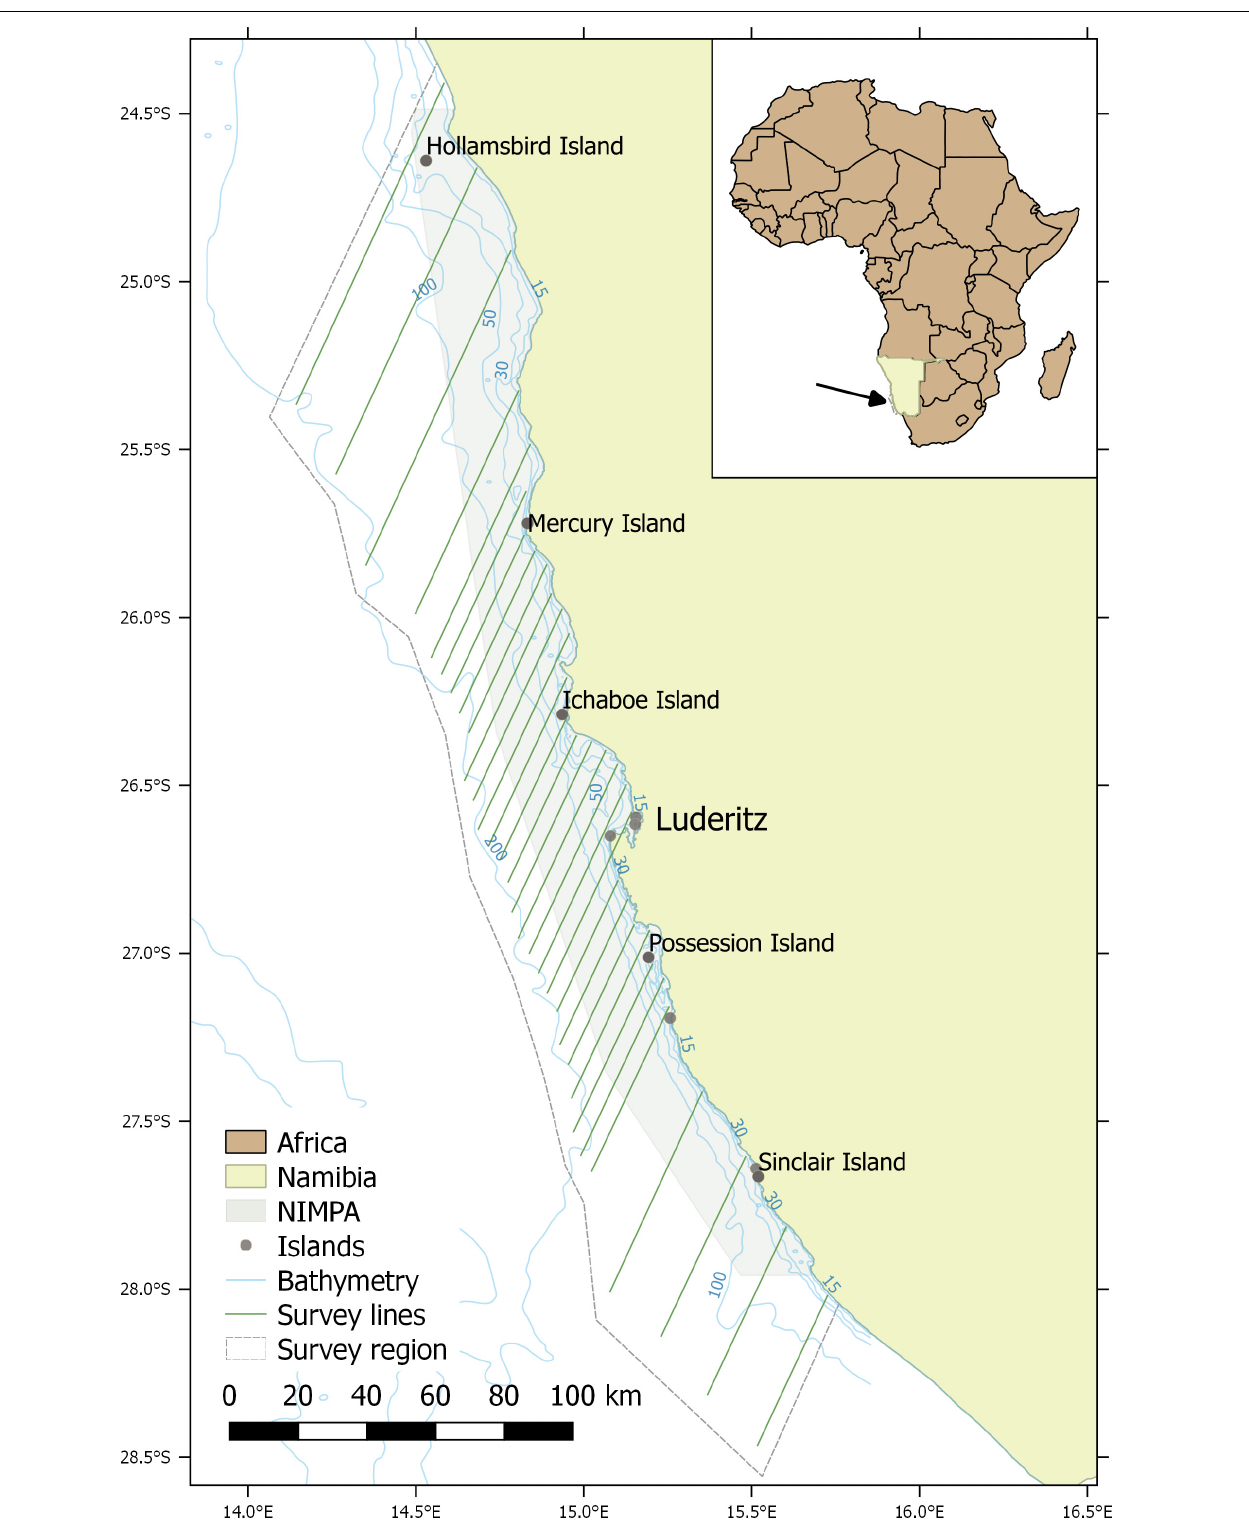
Frontiers in Marine Science |